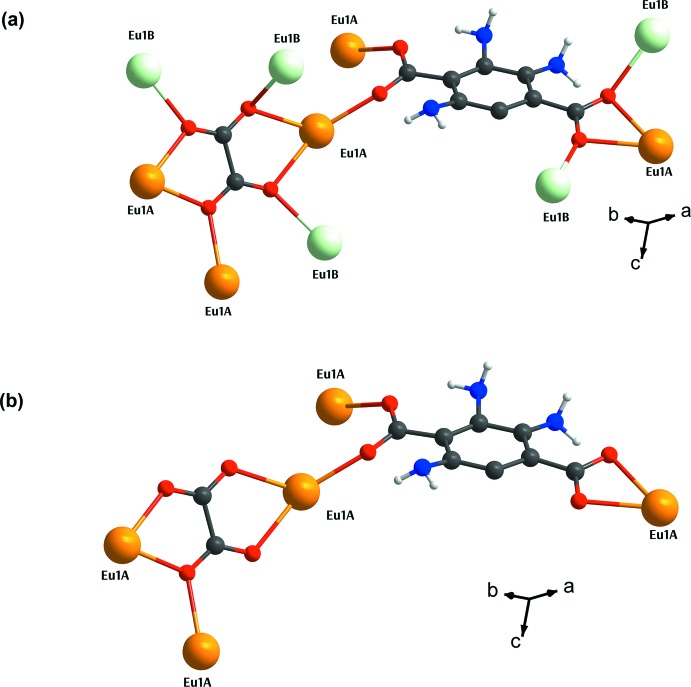
Depictions of coordination modes adopted by NH2—BDC2− and ox2−; (a) with (b) without Eu1B.